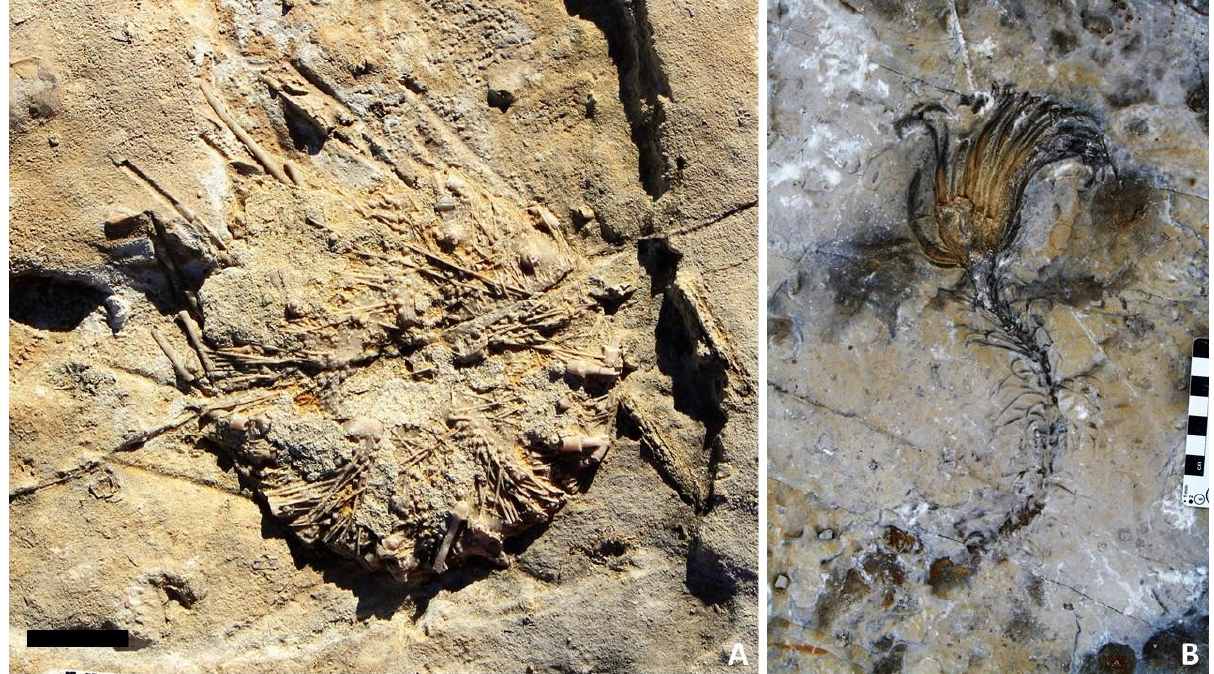
Figure 3. Example of the exceptional preservation of echinoderms at the Cabeço da Ladeira site. ( A ) Gymnocidaris cf. guerangeri (Cotteau, 1857) with the spines still attached; scale is 1 cm; ( B ) a complete isocrinid crinoid evidencing the fine peduncle cirri; the scale squares are 1 cm in length. Photos taken in the field by the authors.